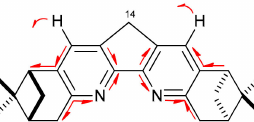
Figure 1. Principal synchronous atoms displacements of the skeletal vibrational mode resulting in the most intensive IR band at 1392–1398 cm − 1 in accordance with DFT calculations (vibrations of the pinane moiety are not shown).